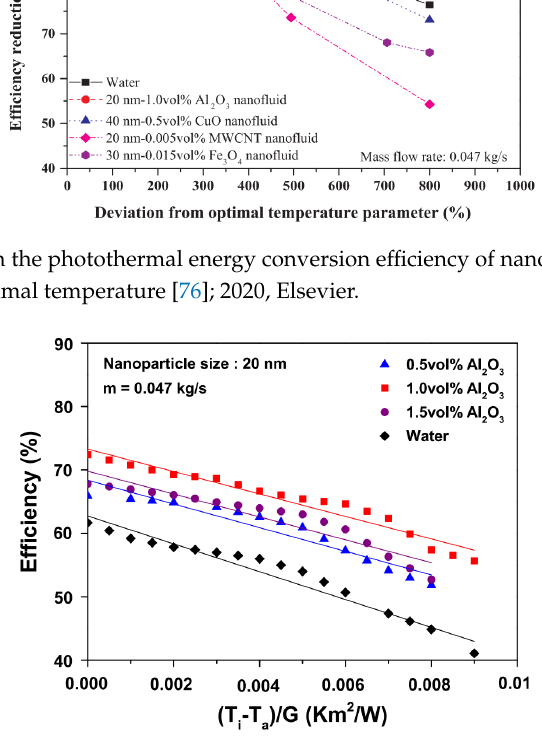
Figure 22. Variation of the efficiency of a U-tube solar collector as a function of nanoparticle size (nanofluid concentration: 1vol%, m = 0.047 kg/s) [78]; 2017, Elsevier.